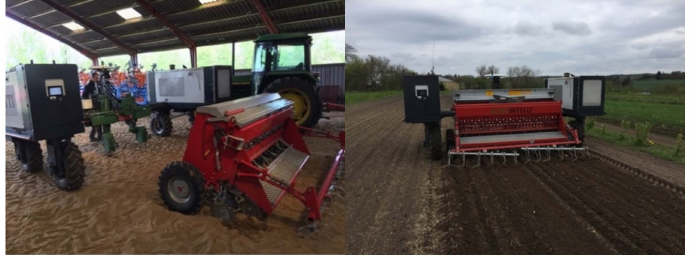
Figure 4. Grain drill seeder, 3 (m)/25 rows, 5 (km/h), 4 (cm) depth. The seeder was filled with weights in the center to represent the weight of the seed. Total weight 210 (kg) (4 × 30 (kg) + 2 × 45 (kg)).